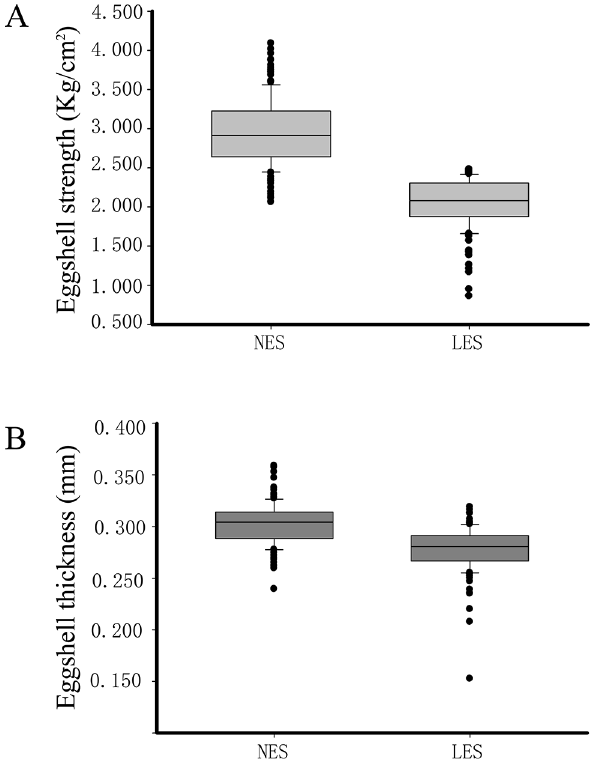
Fig 2. The eggshell strength (A) and eggshell thickness (B) in the normal eggshell strength (NES) group and the low eggshell strength (LES) group. There are 154 and 159 individuals for the NES group and LES group, respectively.